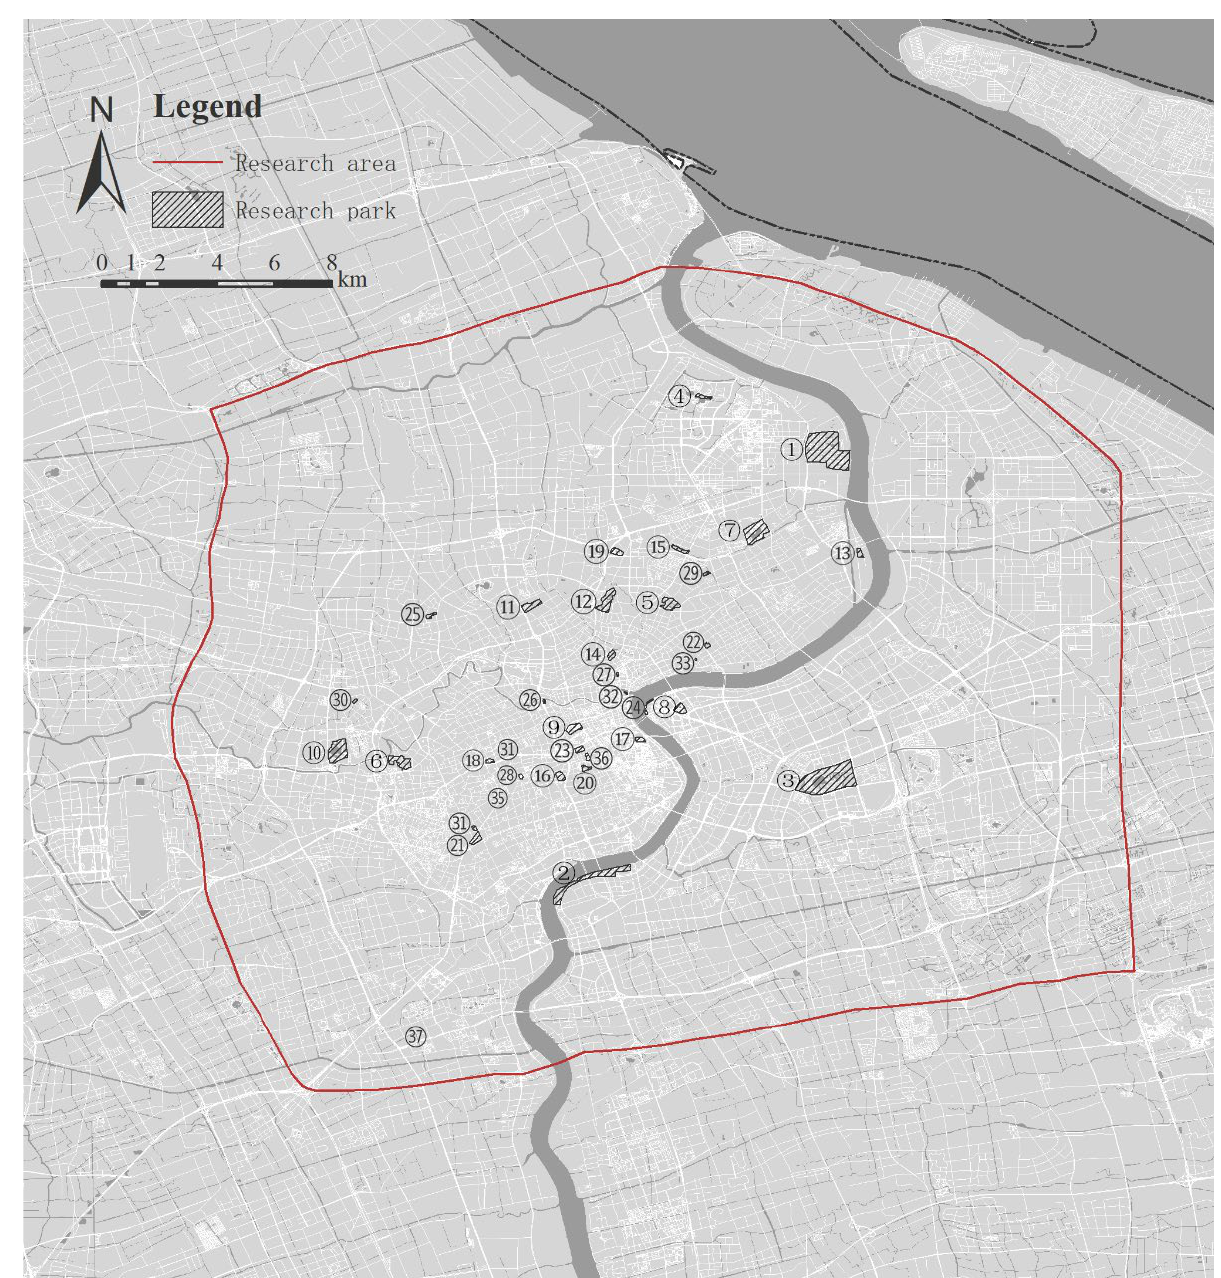
Figure 2. Study areas are urban parks in central Shanghai. Table 1. The Urban parks information table.